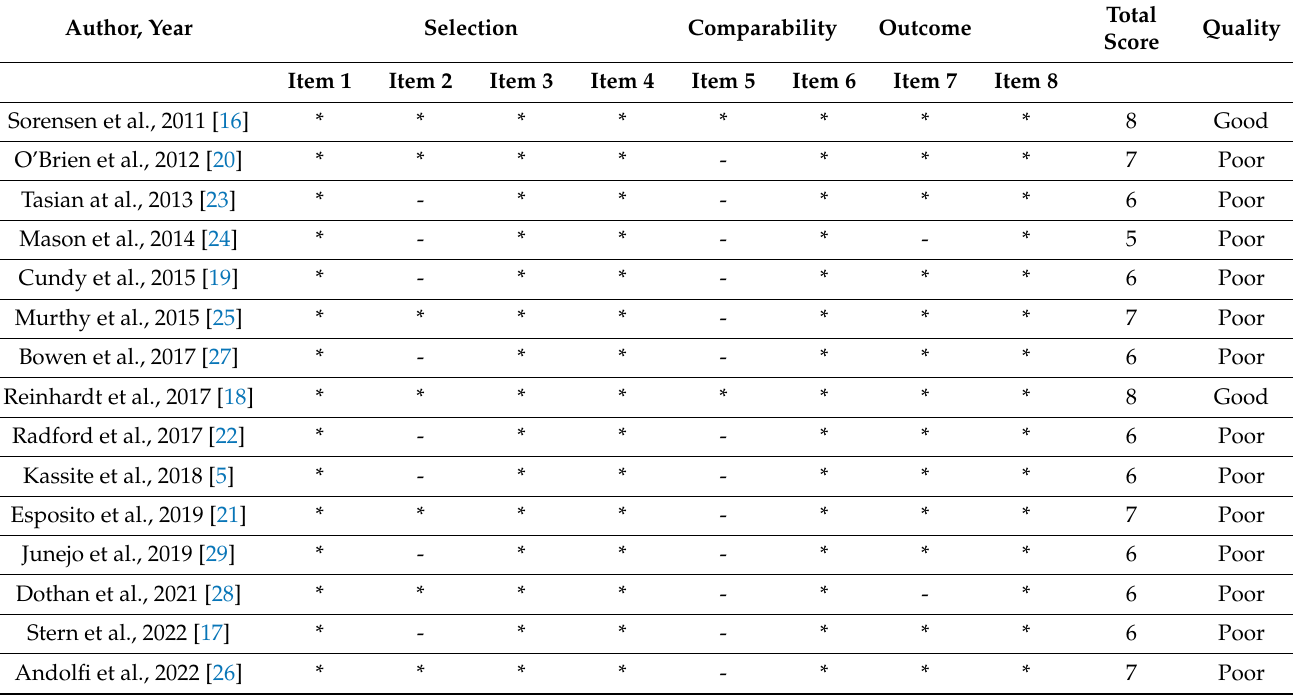
Table 3. Methodological quality assessment utilizing the Newcastle–Ottawa